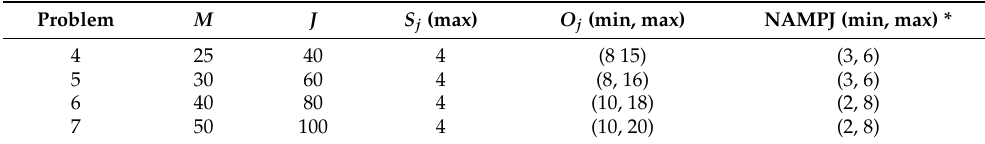
Table 14. Basic features of the problems considered for performance evaluation of the proposed algorithm.